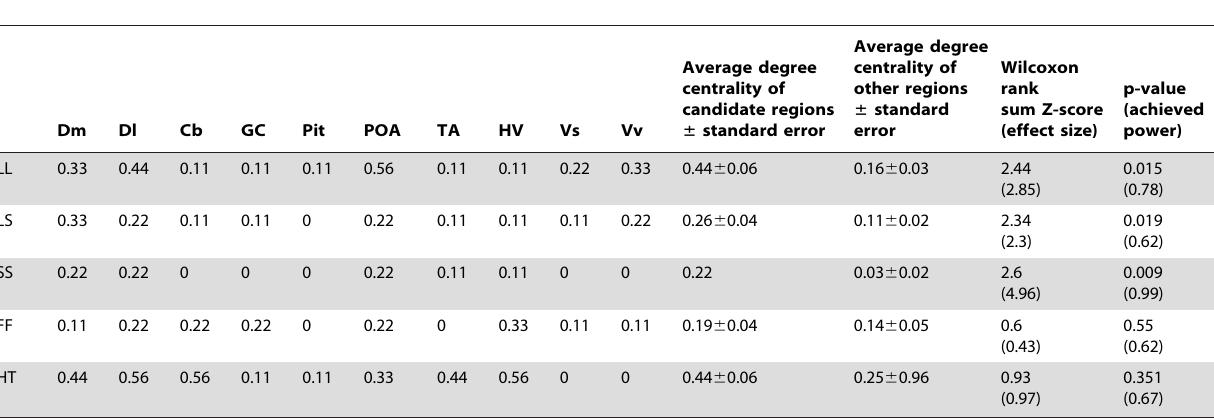
Table 3. Degree centrality of neuroserpin by social context for each brain region, in each treatment group for females used to localize neuroserpin .